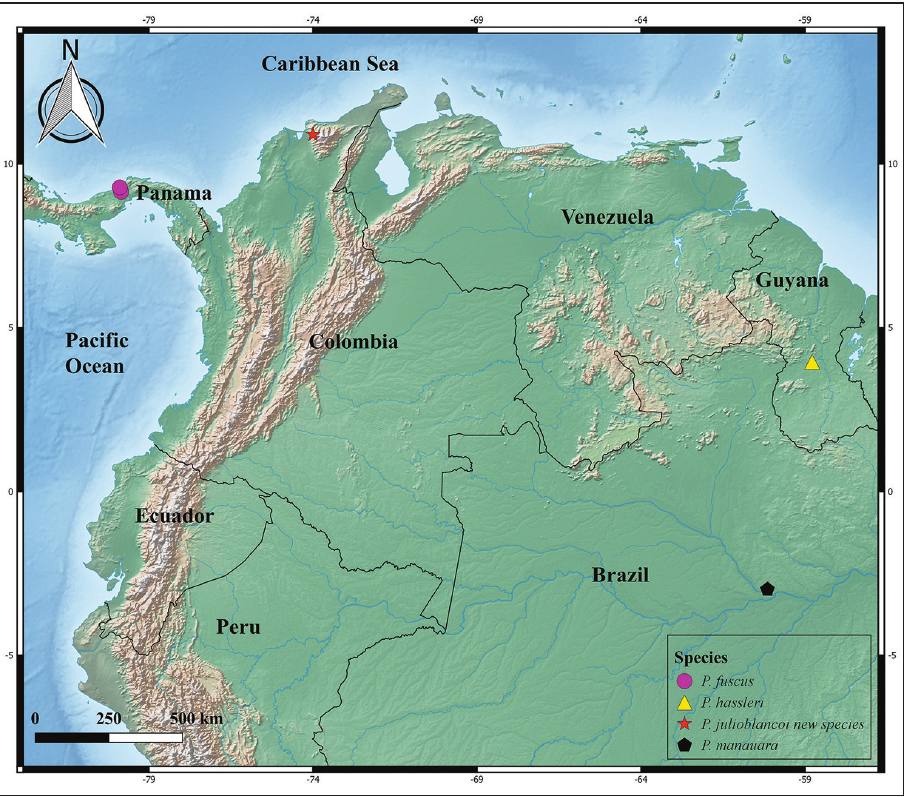
Figure 3. Distribution of the species of the genus Parachemmis in South